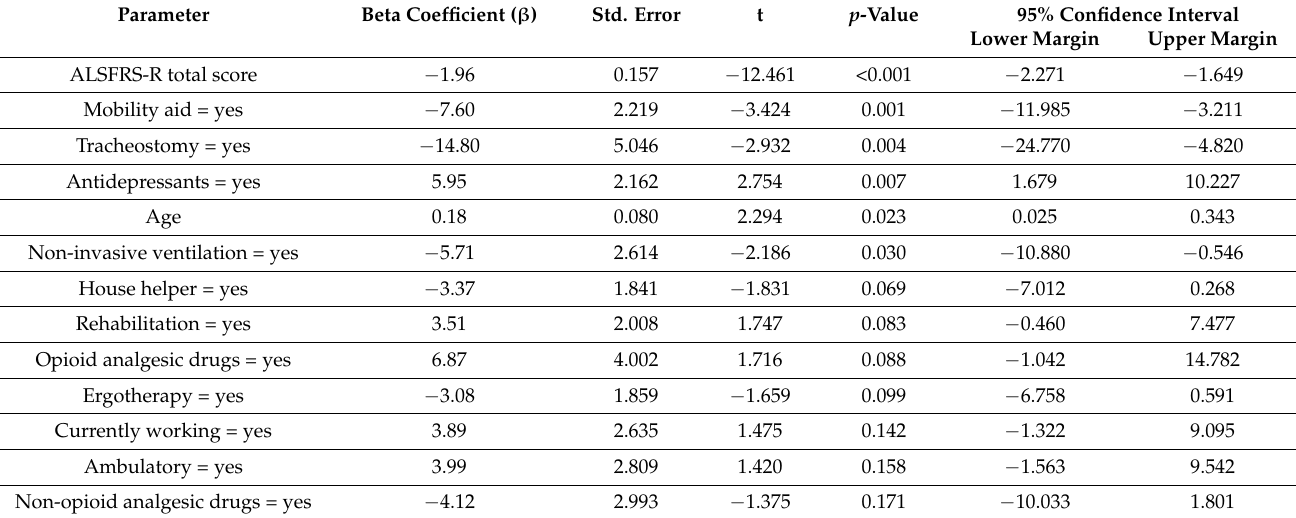
Table 2. The final multiple linear regression model that showed the influencing factors on QoL in ALS, with the ALSAQ-5 total score being the dependent variable. It included variables that were statistically significant in the simple linear regression model ( p -value ≤ 0.05) and were analyzed in a multiple regression model, which performed a backward selection. The results are arranged by p -values. The maximum n included in the analysis was 288, as this equaled the total number of fully answered ALSAQ-5 questionnaires. Abbreviations: ALS, amyotrophic lateral sclerosis; ALSAQ-5, Amyotrophic Lateral Sclerosis Assessment Questionnaire 5; ALSFRS-R, Revised Amyotrophic Lateral Sclerosis Functional Rating Scale; QoL, quality of life; Std. Error, Standard